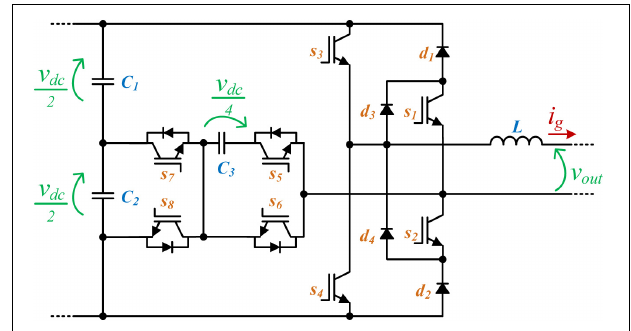
FIGURE 6 | Topology proposed in He and Cheng (2016).